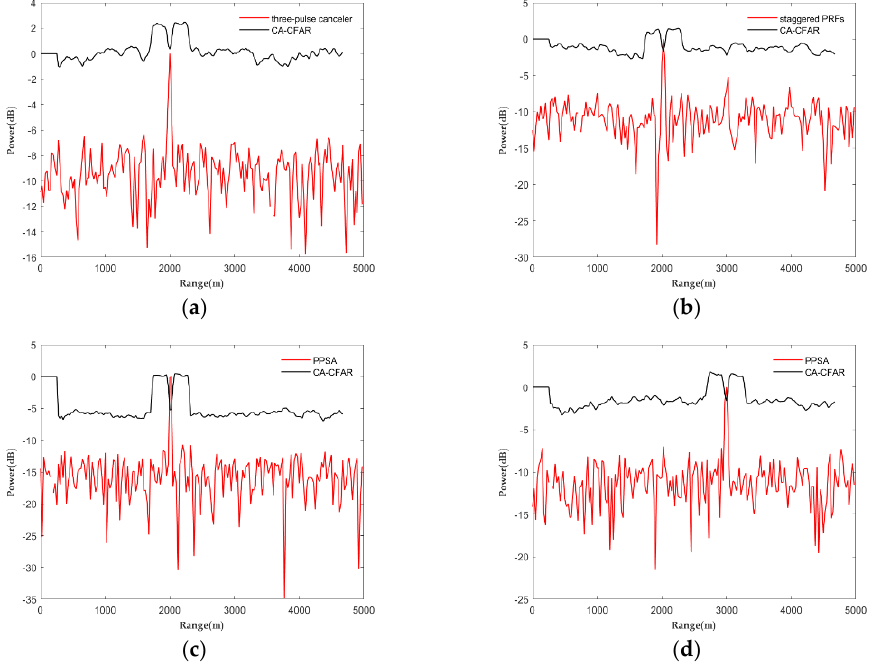
Figure 11. The CFAR detection results for TPC, SPC, and PPSA. ( a ) The result of TPC, ( b ) the result